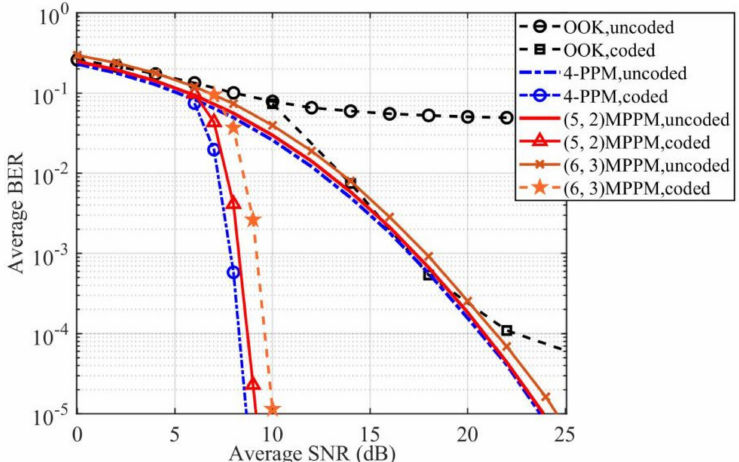
Figure 6. BERs of the UWOC systems with different modulation schemes in the GG fading channel with a scintillation index of σ 2 = I